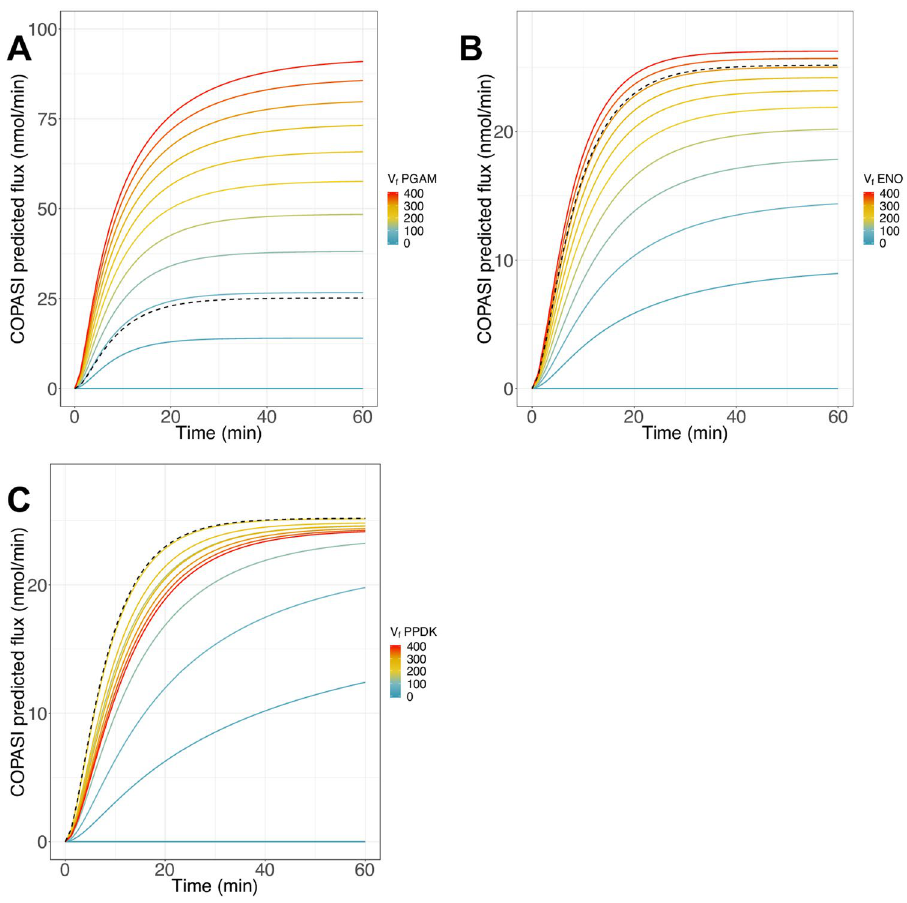
Figure 8. Effect of enzyme variation on the pathway flux. Pathway flux predicted with the model with the added adjustment term, when PGAM activity ( A ), ENO activity ( B ) or PPDK activity ( C ) is varied. Dotted curves: fluxes obtained at the quasi steady-state to Lac. V f of PGAM, ENO and PPDK are in